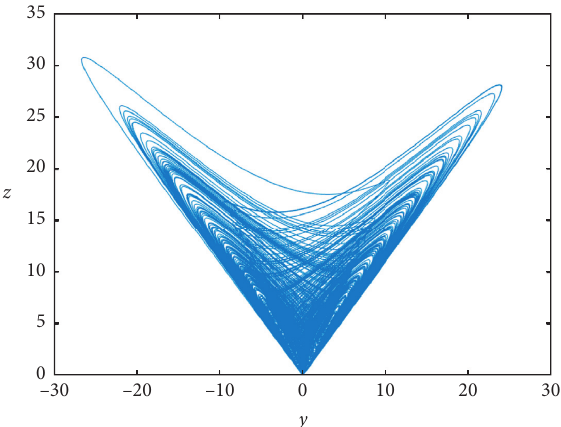
Figure 2: Dynamics of Lu et al.’s fractional-order system in (13)–(15) with the order α � 0 . 92, in context of y and z directions.